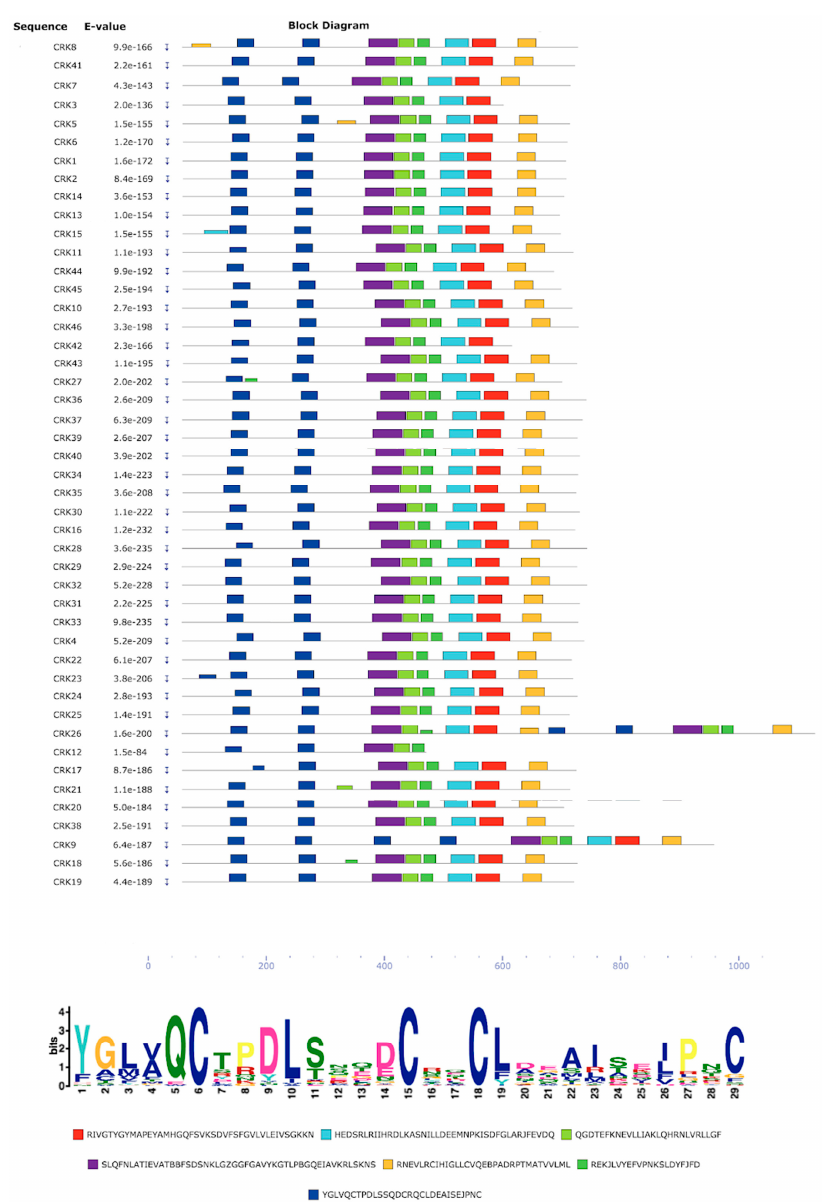
Figure 3. Identification of motifs in CRK protein sequences. MEME was used to identify motifs in the 46 P. vulgaris CRKs. Significantly overrepresented motifs are graphically depicted by bars corresponding to their predicted position. The dark blue bars are analogous to salt stress response/antifungal domain (PF01657), and the corresponding sequence logo is shown in the lower section, in which conserved amino acids are represented by one-letter abbreviations. The red boxes represent kinase domains (PF00069) and light blue represents Pkinase_Tyr (PF07714).